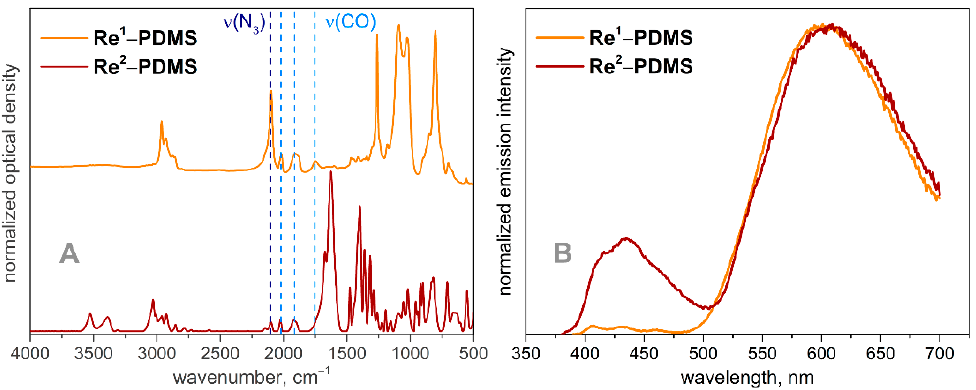
Figure 2. Aliphatic (top) and aromatic (bottom) regions of 1 H NMR spectra (acetone-d 6 , r.t.): ( A ) the initial Re1 complex; ( B ) reaction mixture after 2-day reaction; ( C ) reaction mixture after 5-day reac- tion.